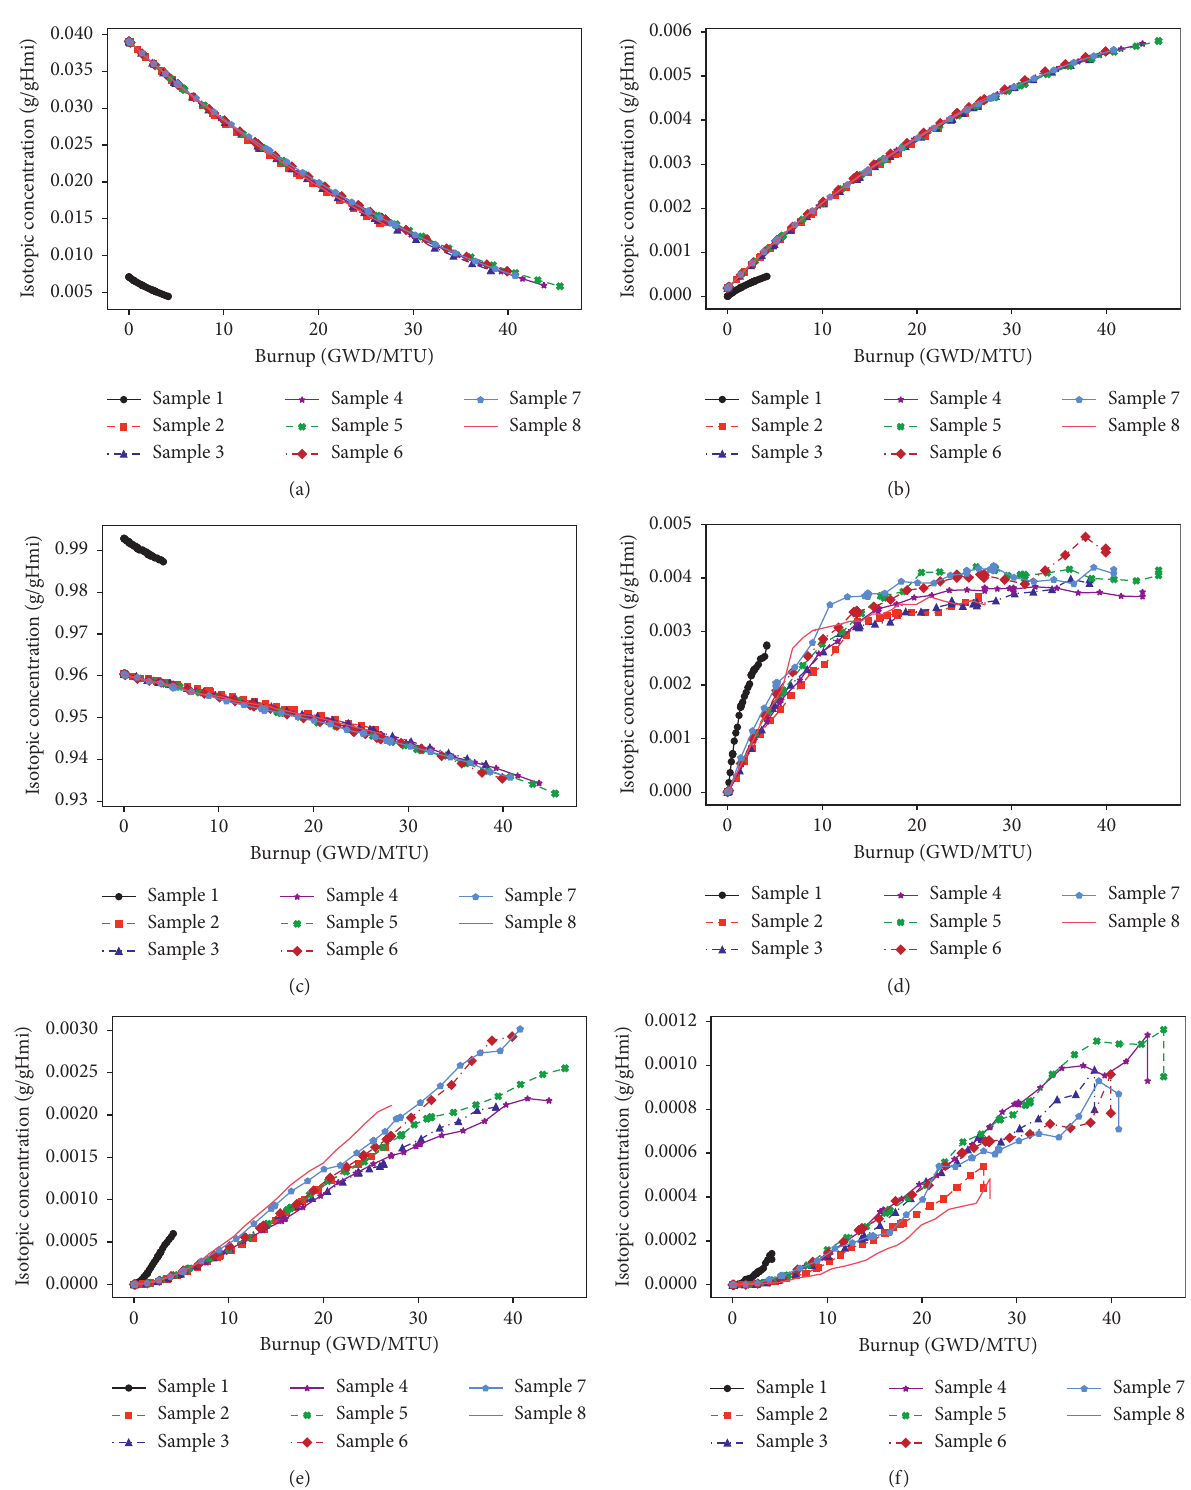
Figure 10: Variation of isotopic concentrations of six major actinides with burnup for the 2F2DN23/SF98 rod. Note: g/gHmi means that the isotope mass (g) is normalized to the grams of heavy metal observed initially at beginning of cycle. (a) U-235. (b) U-236. (c) U-238. (d) Pu- 239. (e) Pu-240. (f)